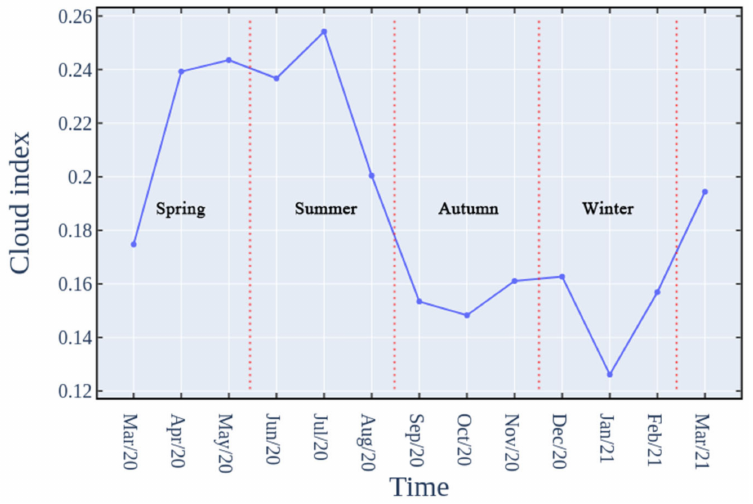
Figure 7. Monthly statistics of laser data points affected by cloud scattering from 2020 to